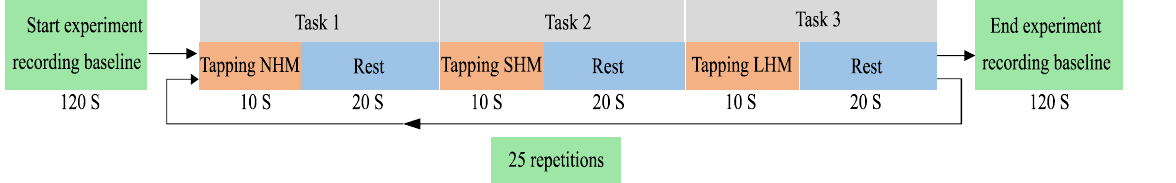
Figure 3. The experimental procedure and sequence of the tasks. The participants first performed hand tapping without head movements for 10 s (NHM), then, after a 20 s rest period, hand tapping with small head movements (SHM) for 10 s, and, after a 20 s rest period, hand tapping with large head movements (LHM) for 10 s, followed by a 20 s rest period. This sequence was repeated 25 times. A baseline was recorded at the beginning and the end of the experiment.